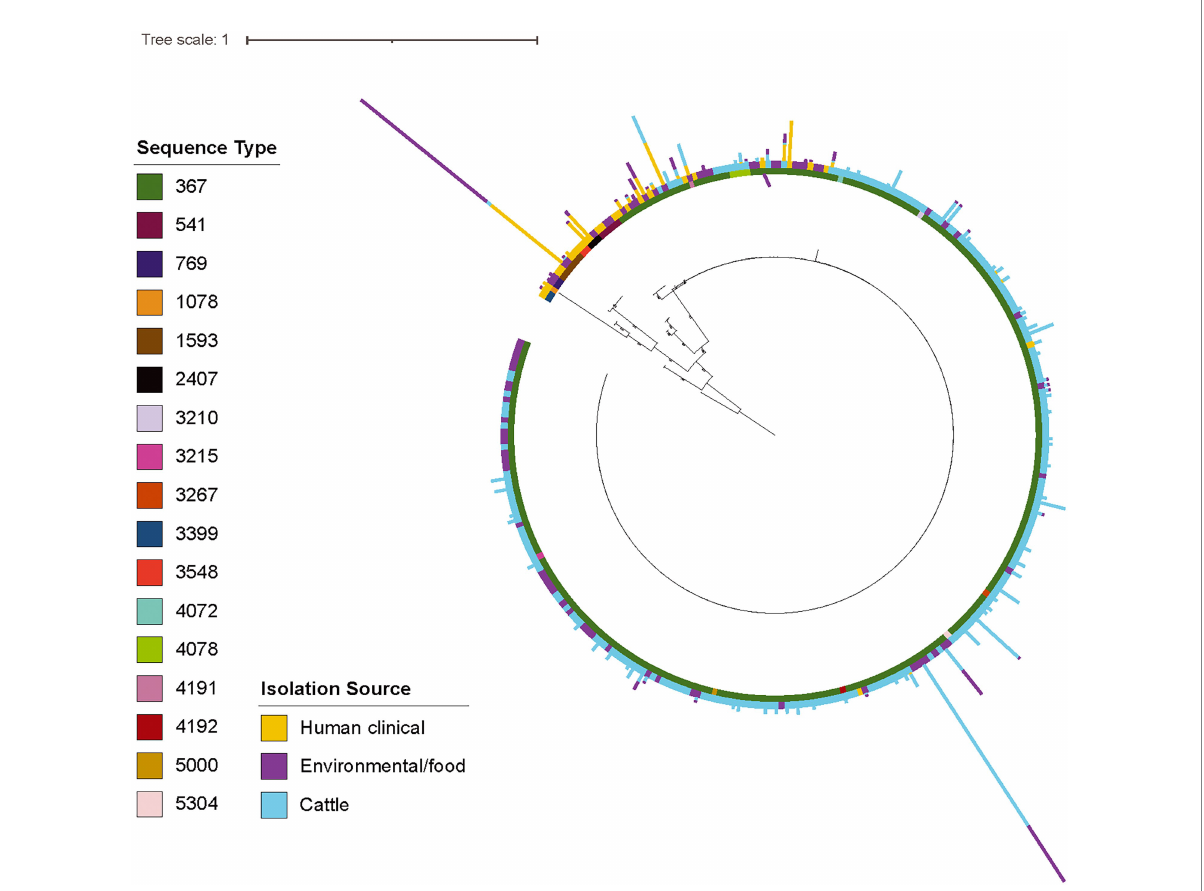
FIGURE 2 The majority of S. Cerro cattle isolates cluster within a large, clonal clade within subsp. enterica section Typhi while human clinical isolates represent more diverse lineages. Maximum likelihood phylogenetic tree constructed from core SNPs identified with kSNP3 (Gardner and Hall, 2013) for (i) representative isolates of section Typhi S. Cerro SNP clusters included in NCBI Pathogen Detection as of 1/20/20 and (ii) a previously published set of S. Cerro isolates (Kovac et al., 2017); S. Orion GCA_003874655 was included as an outgroup to root the phylogeny as it shares a MRCA with section Typhi S. Cerro. Bootstrap values represent the average of 100 bootstrap repetitions and only bootstraps >70 are shown for clades containing >5 isolates. Sequence types, as determined using the 7-gene MLST scheme, are shown in the inner color ring, isolation source (i.e., human clinical, food/environmental, and cattle) is shown in the outer ring, and the number of isolates from each isolation source (i.e., human clinical, food/environmental, and cattle) for the representative isolates’ SNP clusters are represented by the bar graphs shown external to the